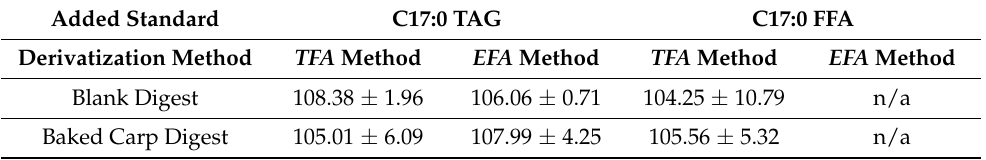
Table 1. Results of the recovery experiment. Concentration of heptadecanoic acid methyl ester [ µ g/mL] in samples spiked with same amount of C17:0 TAG or C17:0 FFA, derivatized with ISO 12966-2:2017 standard method’s TFA method and EFA method as detailed in the text. The C19:0 TAG was spiked at 100 µ g/mL to all samples as well as in calibration solutions as ISTD. Added Standard C17:0 TAG C17:0 FFA Derivatization Method Blank Digest Baked Carp